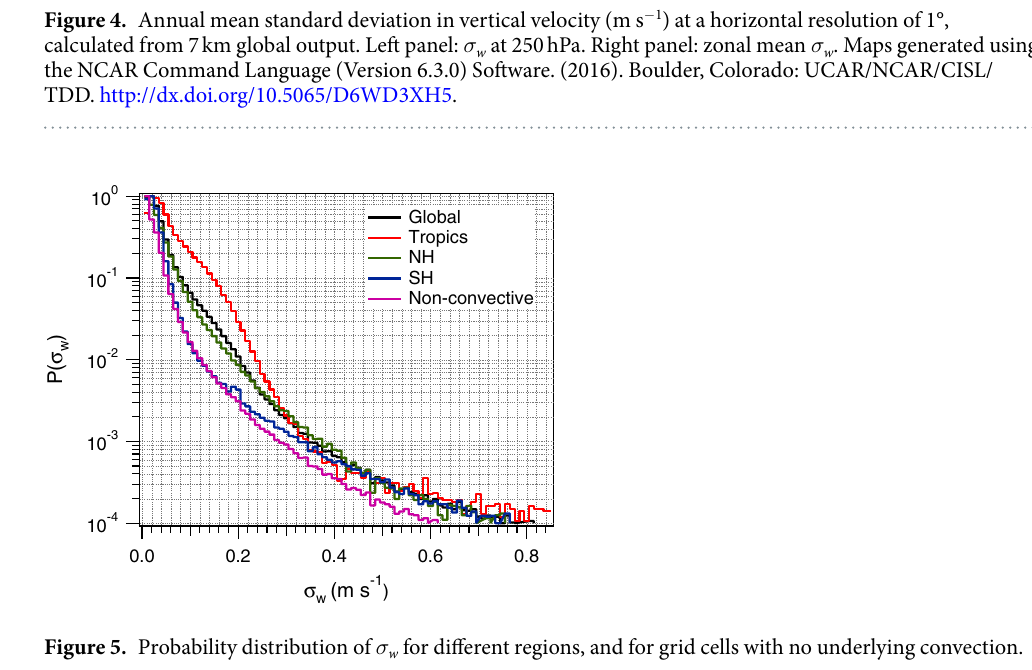
Figure 5. Probability distribution of σ w for different regions, and for grid cells with no underlying